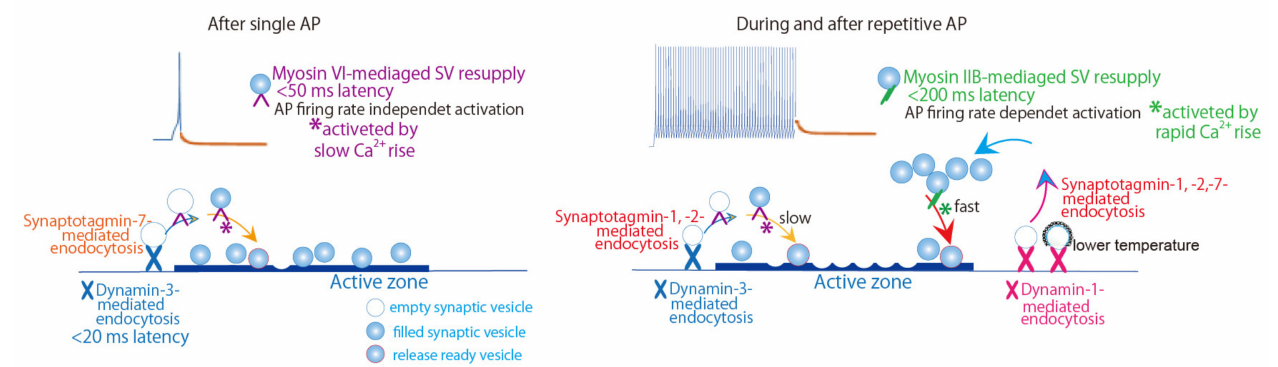
Figure 2. Schematic drawing of a possible linkage of endocytosis to exocytosis through activity- dependent distinct synaptic vesicle recycling pathways in presynaptic sympathetic neurons. (Left) After single action potential (AP), within 20 msec, an endocytic protein, dynamin-3, mediates ultrafast endocytosis, and within 50 msec, a motor protein, myosin VI, resupplies synaptic vesicles (SVs) to the release site. For ultrafast endocytosis, synaptotagmin-7 likely acts as a Ca 2+ sensor. (Right) During and after repetitive APs, recovery pathways of release-ready vesicles with distinct kinetics involves dynamin isoforms, Ca 2+ sensors, and myosin isoforms. For fast recovery, dynamin-1 and myosin IIB are involved, and synaptotagmin-1, -2, and -7 can be mediators for endocytosis. In contrast, for the slow recovery pathway, dynamin-3 and myosin VI are involved, and synaptotagmin-1 and -2 can be mediators for endocytosis. Adapted from Lu et al., 2009 [116], Tanifuji et al., 2013 [114], Mori et al., 2014 [117], Hayashida et al., 2015 [113], and Tanifuji’s unpublished